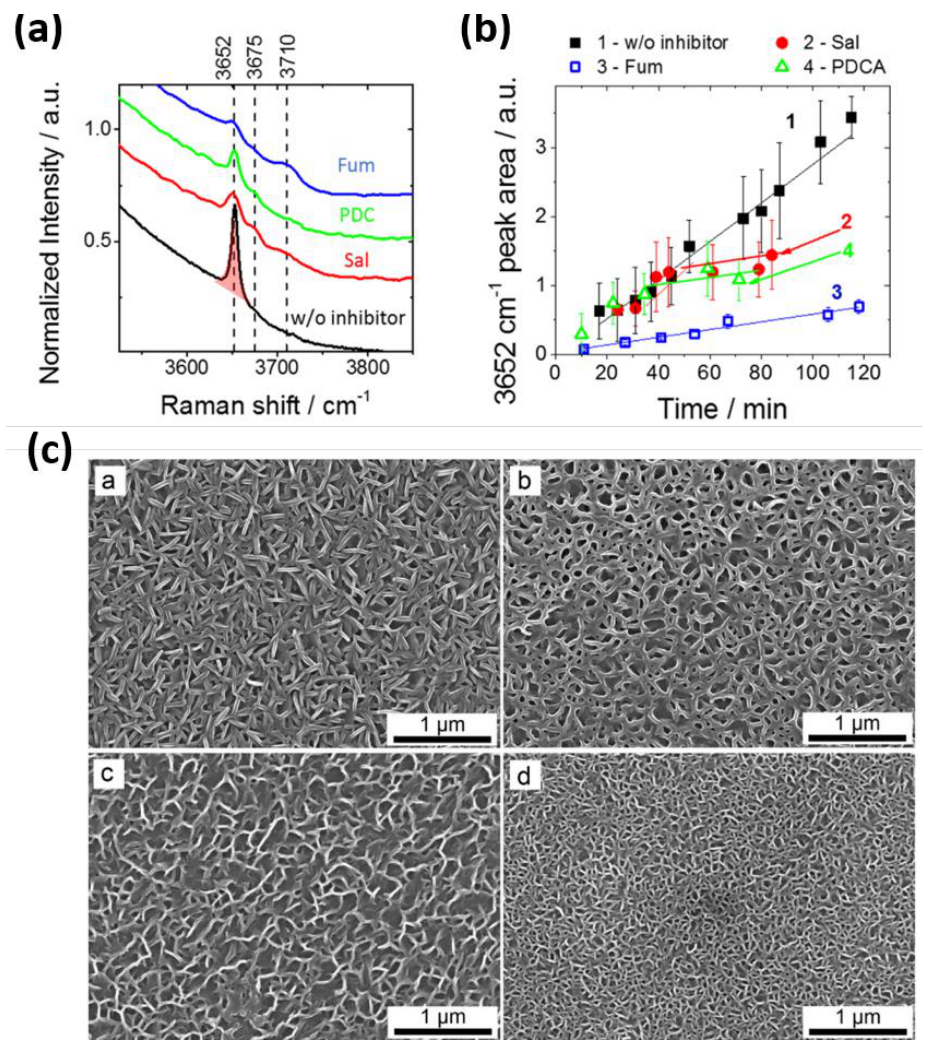
Figure 13. ( a ) Fragments of in situ Raman spectra recorded on CP-Mg342 in 0.1 M NaCl in absence and in presence of corrosion inhibitors; ( b ) growth kinetics of Mg(OH) 2 recorded on CP-Mg342 in 0.1 M NaCl with or without the corrosion inhibitors; ( c ) SEM micrographs of CP-Mg342 surface after 30 min contact with flowing 0.1 M NaCl solution with and without 0.05 M inhibitors ( a : without inhibitors; b : sodium salicylate (Sal); c : 2,5-pyridin-dicarboxylate (PDCA); d : fumarate (Fum)). Adapted from [158] with permission from Elsevier.